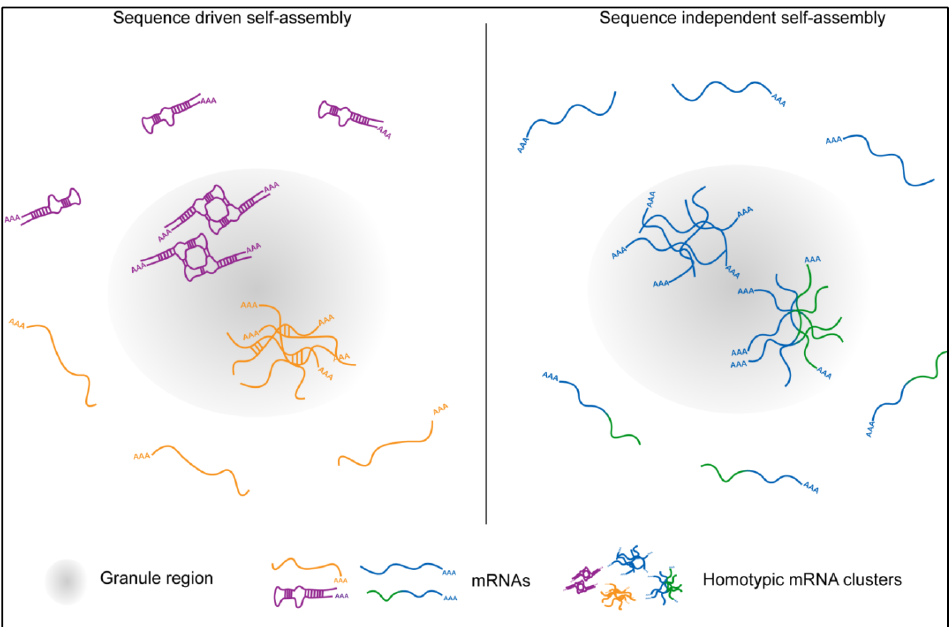
Figure 4. Proposed models showing the mechanisms of mRNA self-organization in RNA granules using sequence-dependent or sequence-independent assembly. The later mechanism was demonstrated for homotypic mRNA clusters in Drosophila germ granules. Here, mRNAs distinguish between endogenous mRNAs and its derivatives and de-mix to form distinct homotypic clusters